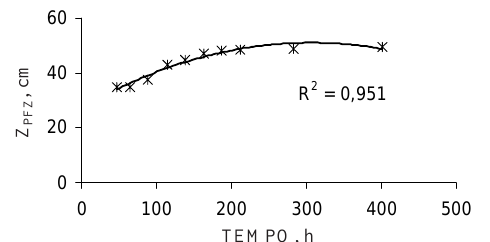
Figura 3. Profundidade do plano de fluxo zero ( z cm) em função do tempo (h) e curva polinomial de segundo grau (Equação 8)